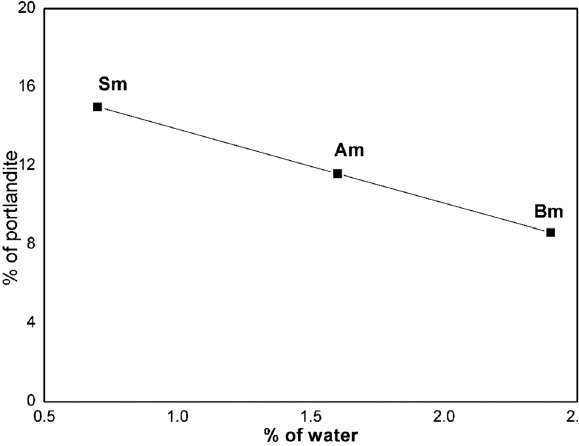
Figure 8: Relationship between the percentage of Portlandite in Am, Bm and Sm vs the water absorption.